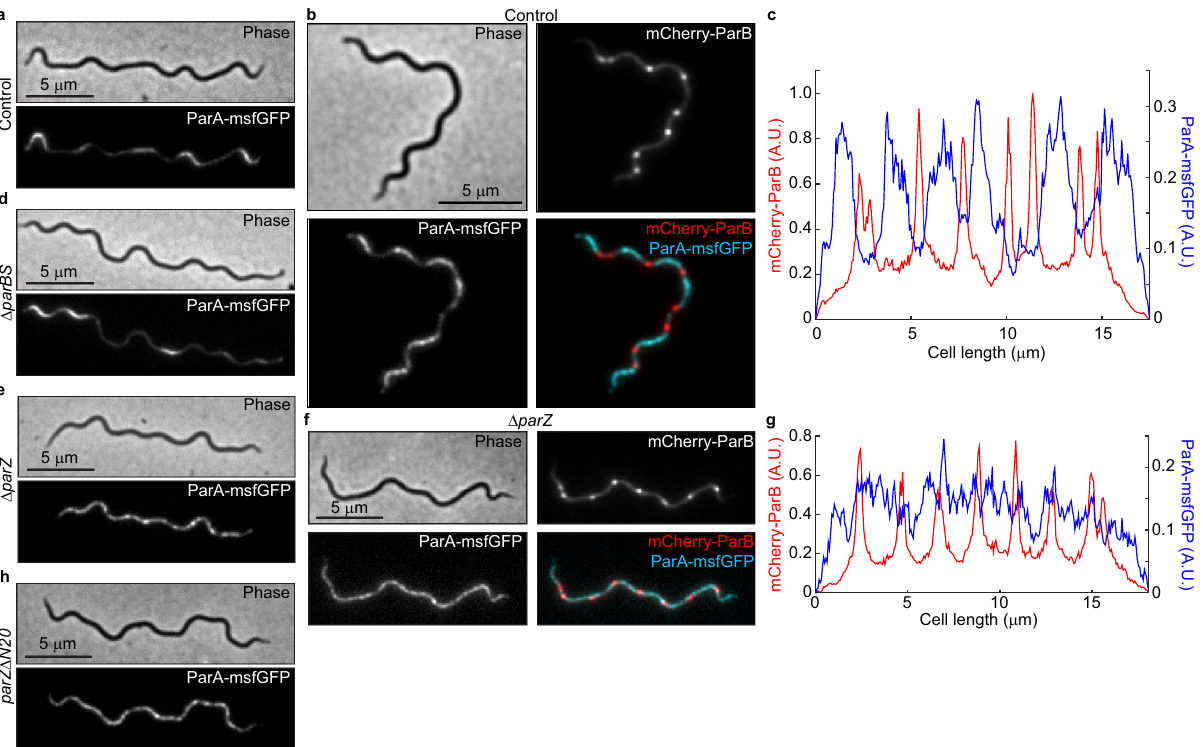
Fig. 7 | ParZ, not ParB, controls ParA localization in B. burgdorferi . a Images of ParA-msfGFP localization in knock-in strain CJW_Bb488, which carries a full com- plement of par genes and thus serves as control for ParA-msfGFP localization. b Images of a cell of strain CJW_Bb538 expressing ParA-msfGFP and in which oriC copies were localized by expression of mCherry-ParB. c Fluorescence intensity pro fi les along the cell length for the cell shown in ( b ). d Images of ParA-msfGFP localization in knock-in strain CJW_Bb520 in which parBS is deleted. e Images of